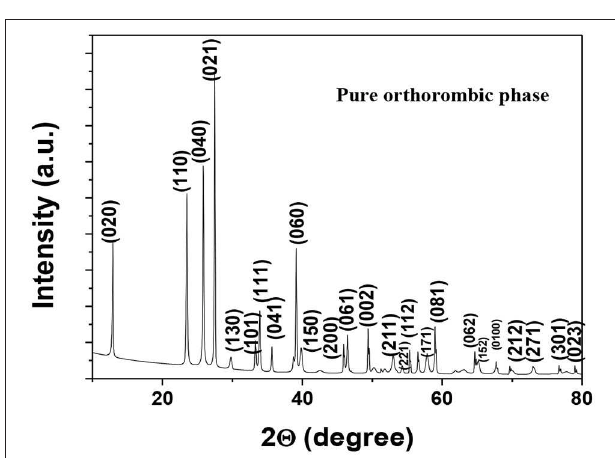
FIGURE 3 | X-ray diffraction pattern of α -MoO 3 calcined at 500 ◦ C.